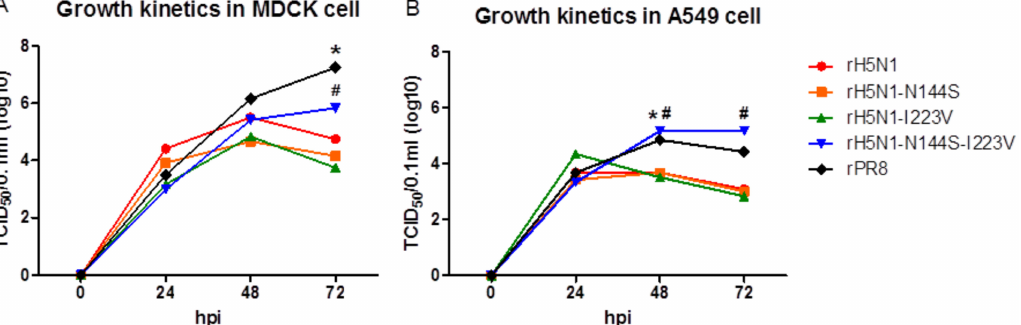
Figure 1. Growth kinetics of recombinant H5N1 viruses in MDCK and A549 cells. Each recombinant virus was diluted to 10 5 50% chicken embryo infection dose (EID 50 ) / 0.1 mL, and 0.5 mL of diluents were